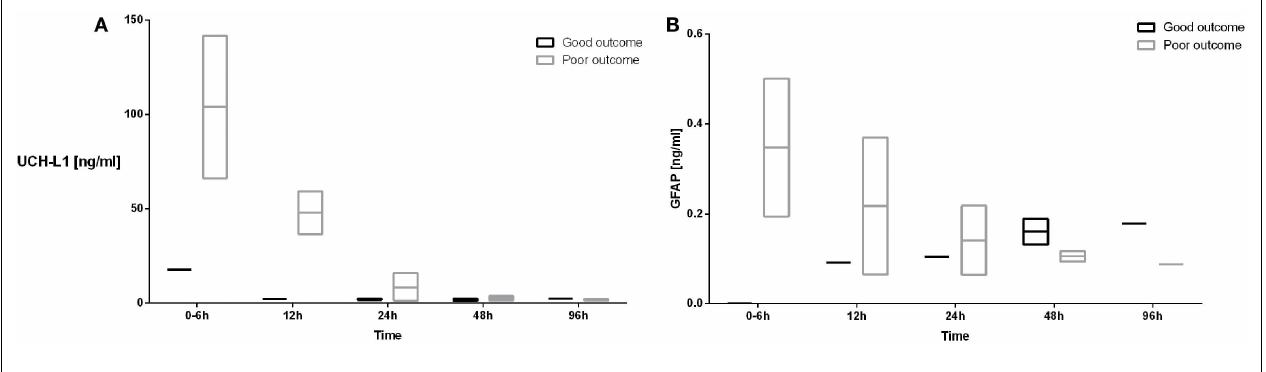
96h sampling period .The mean serum concentrations are represented by the line while the bar represents the minimum and maximum serum